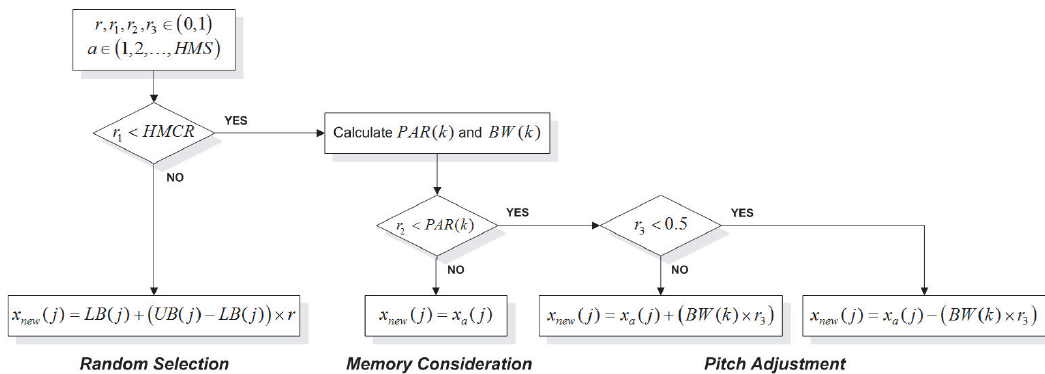
Figure 8. Improvisation process in Improved Harmony search (IHS)